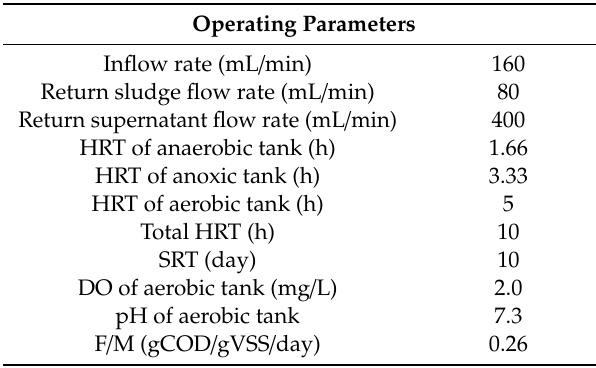
Table 5. A 2 O operating